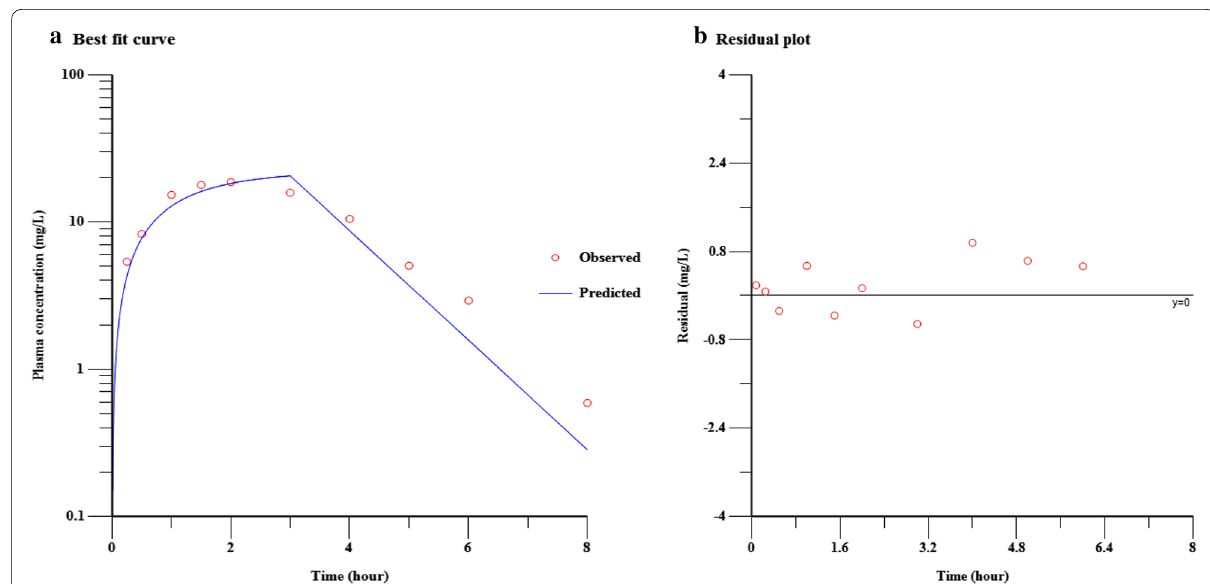
Fig. 1 The best fit curve ( a ) and the residual plot ( b ) of a representative patient showing one-compartment PK fitting of meropenem. a Open red dots represent meropenem concentrations at different sampling times. Curve fitting is a mathematical function that has the best fit to a series of data points. b Random distribution of residuals, i.e., difference between the observed concentration and that predicted by the model on the residual plot indicates that the model is appropriate for the data